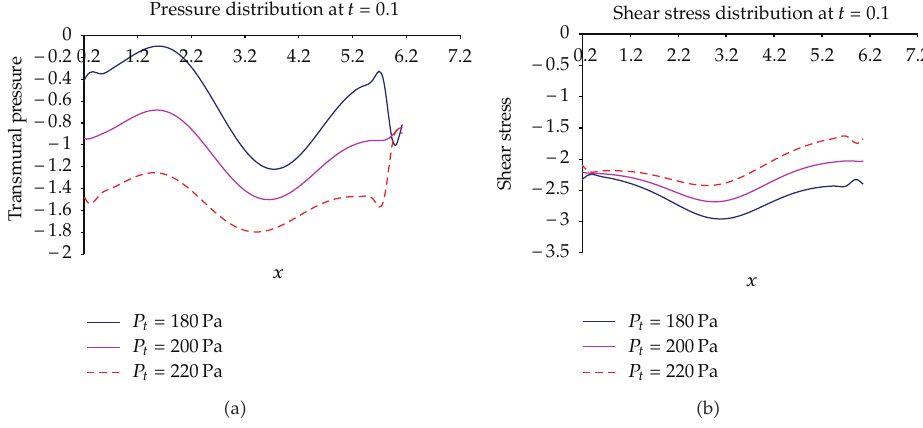
Figure 7: Distribution of pressure (cid:3) a (cid:4) and wall shear stress (cid:3) b (cid:4) , for inlet transmural pressure of 180Pa, 200Pa and